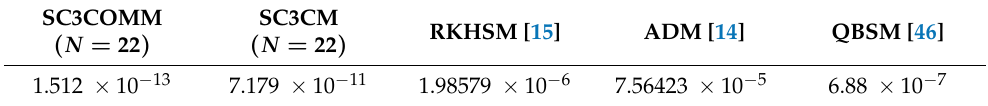
Table 6. Comparison between different methods of Example 4.